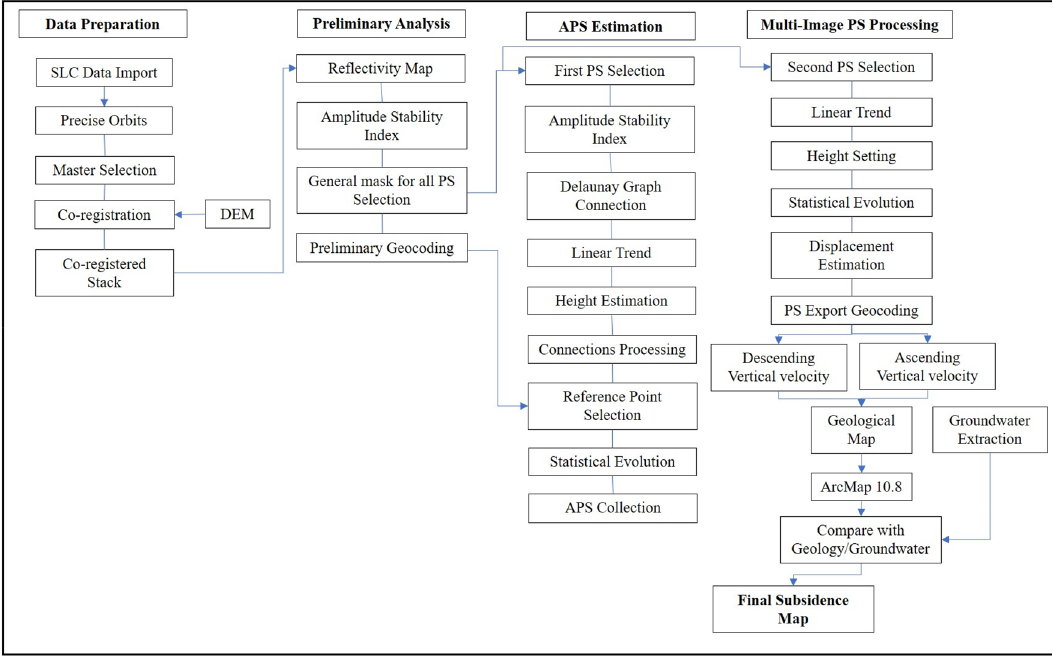
Figure 4. Flowchart of the